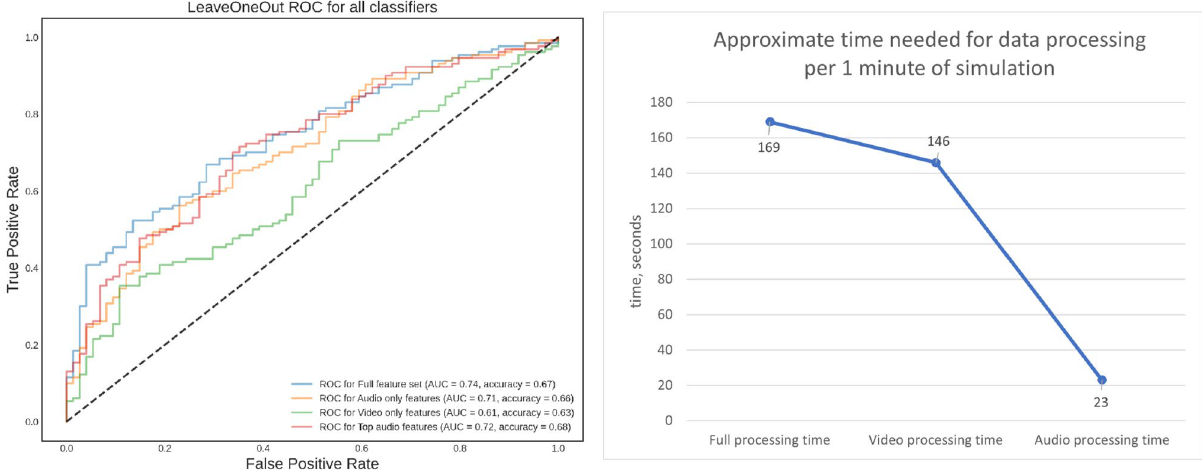
Figure 2. Left: ROC curves for the SVM trained on full feature set, audio only, video only, and top selected features. Right: Approximate time needed for data processing per one minute of simulation, in seconds. By removing video features, computing time was reduced by